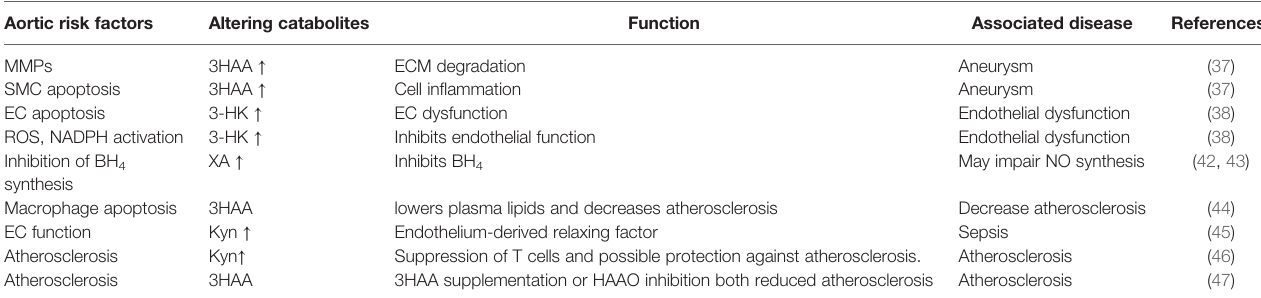
TABLE 1 | Kynurenine metabolic members associated with aortic